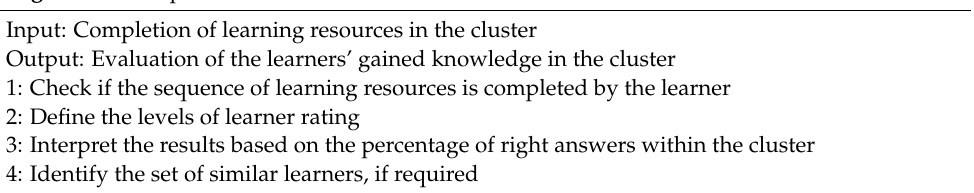
Algorithm 4 Proposed Cluster-Based